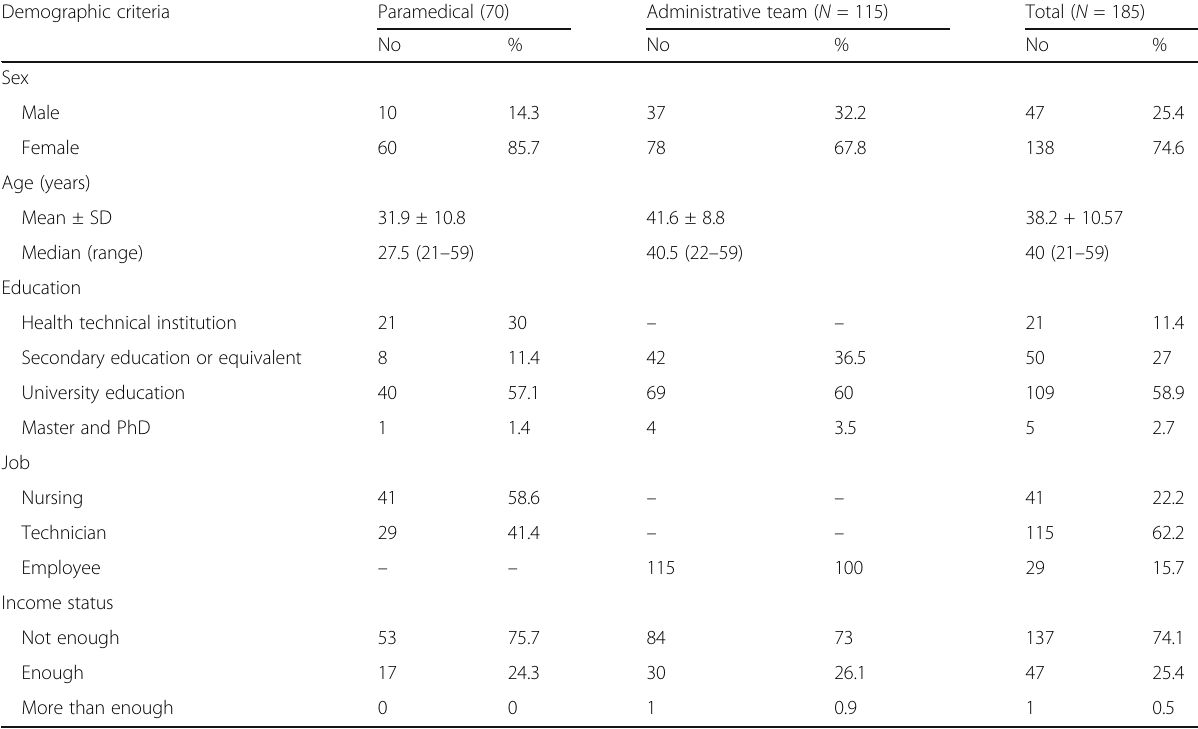
Table 1 Sociodemographic data of paramedical and administrative team of our studied participant at the National Liver Institute of Menoufia University Demographic